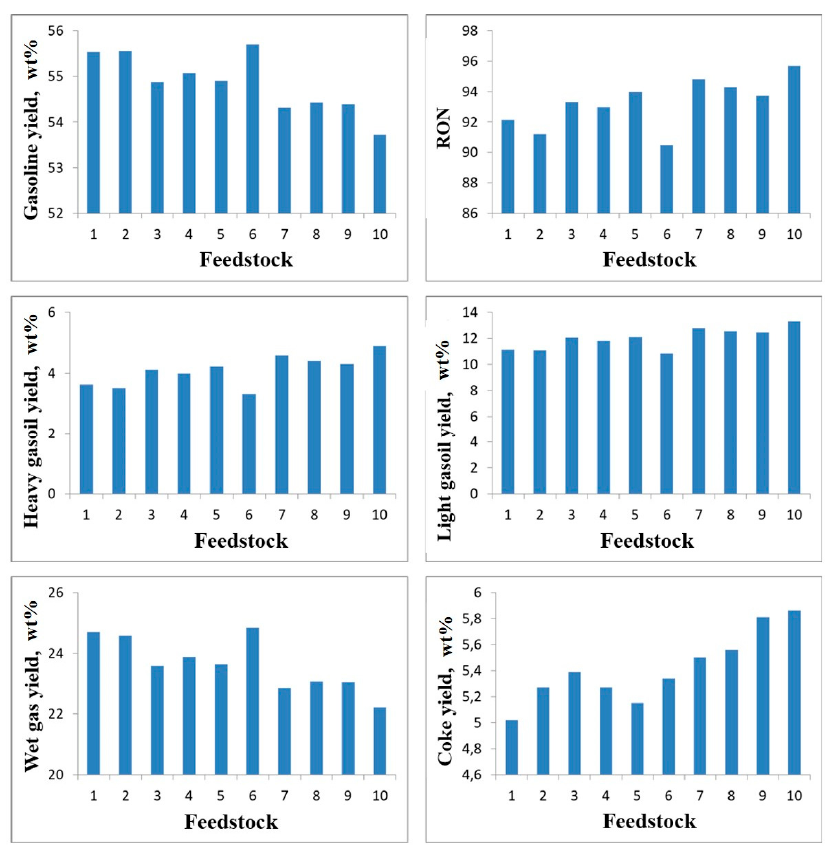
Figure 4. The sensitivity of the model to SAR content in Figure 4. T he sensitivity of the model to SAR content in feedstock.